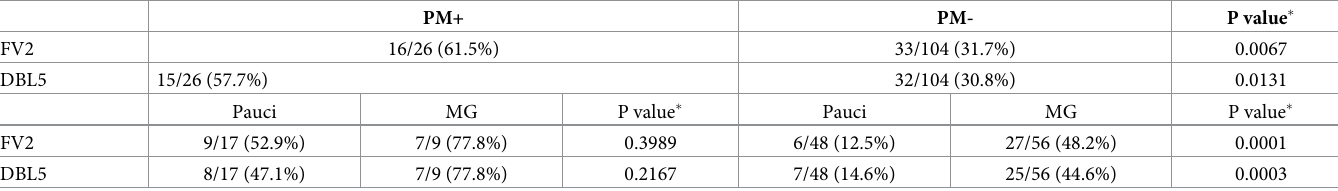
Table 2. Percentage of women with antibodies to VAR2CSA (FV2 and DBL5) at delivery by PM and gravidity